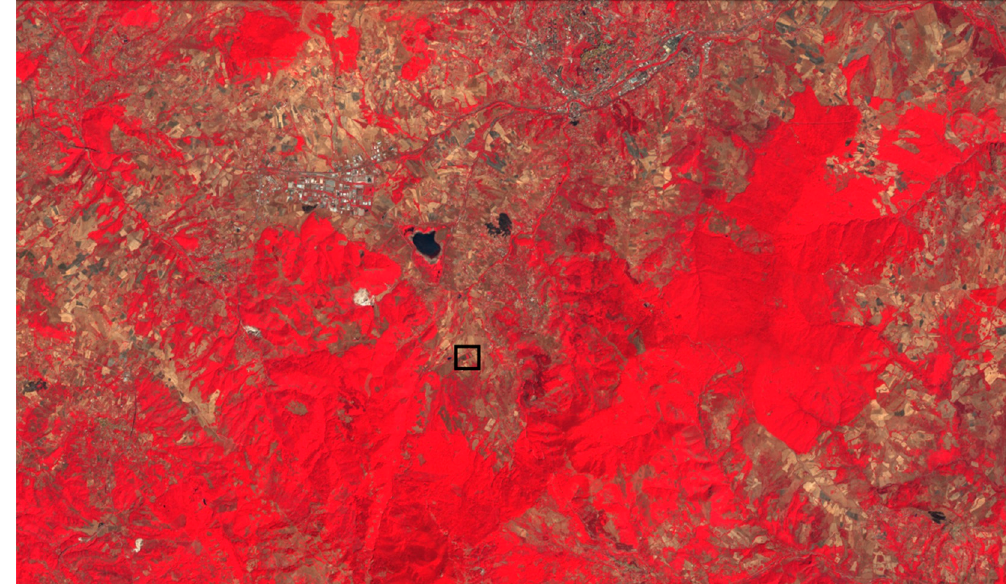
Figure 2. Example of a S2 (R: 842 nm; G: 560 nm; B: 490 nm) imagery acquired on the study area (black box) in 2017 (6 August 2017; center coordinates of the black box/zoom image are: 40°33 ′ 37.54 ″ N and 15°45 ′ 40.64 ″ E).